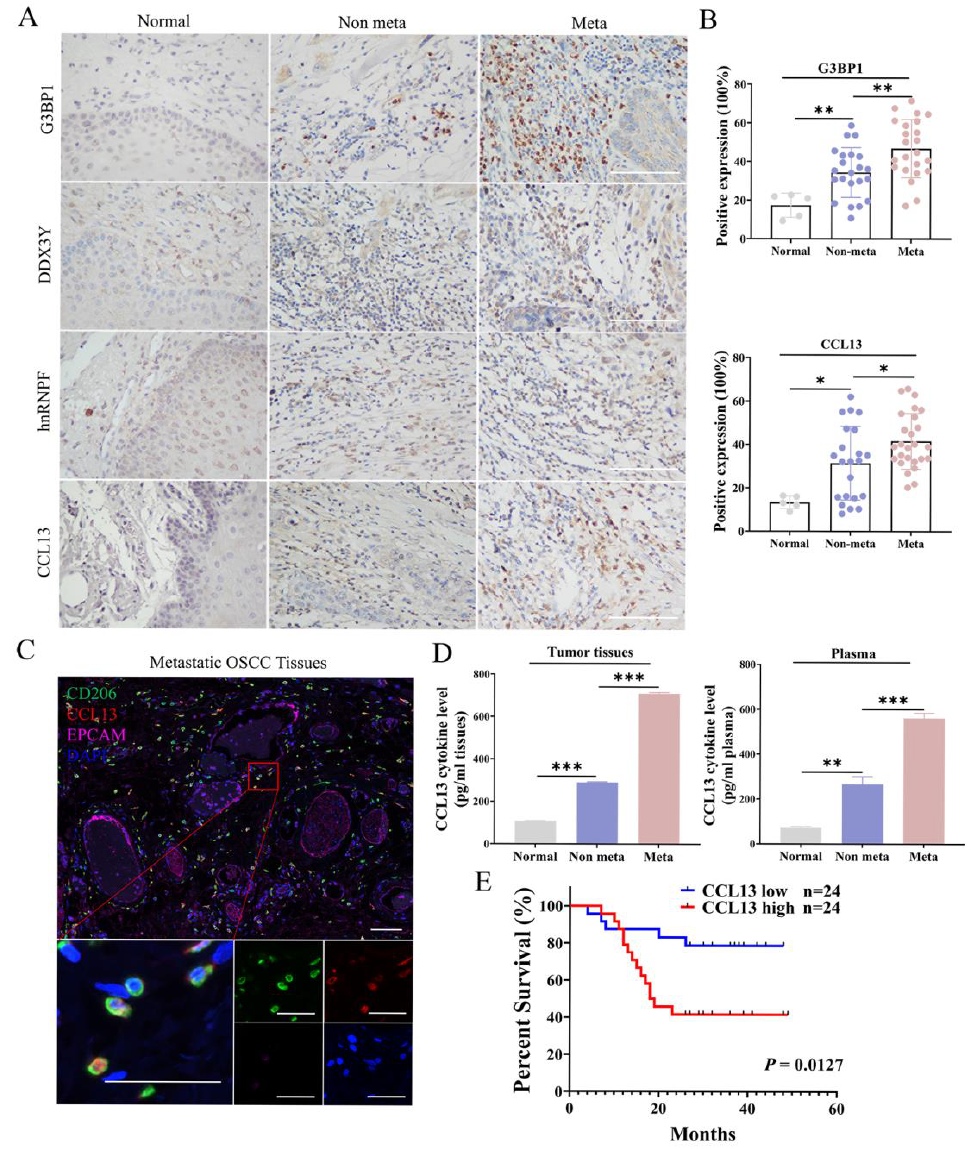
Figure 7. CCL13 was a significant indicator for prognosis of OSCC patients. ( A , B ) Representative images of IHC staining showed that metastasis OSCC with higher G3BP1 and CCL13 levels. Scale bar, 10 μm. Statistical analysis of positive staining of indicated proteins in 22 OSCC patients without metastasis or 26 OSCC patients with metastasis. ( C ) The images of mIHC staining showed the co-localization of CD206 and CCL13 in metastatic OSCC tissues. Scale bar, 50 µ m. Enlarged pictures were inserted on the bottom. Scale bar, 10 μm. ( D ) CCL13 levels from tumor tissues or serum of OSCC patients were tested by ELISA. Bars correspond to mean ± SD of 3 independent experiments.